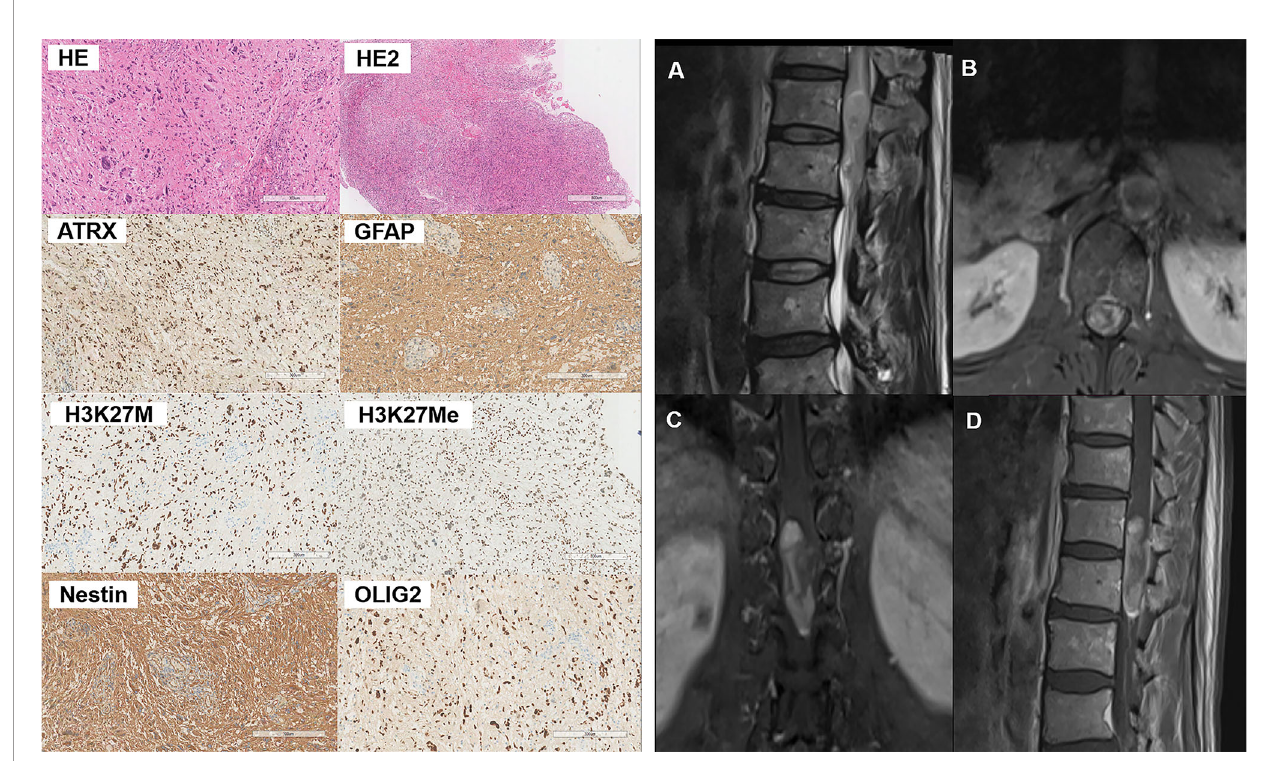
FIGURE 1 | Pathological and radiographical manifestations of the Case 4 patient. Left: Results of HE and immunohistochemical staining of the tumor tissues. Right: MRI images of the tumor that was located at the T12-L1 level. The tumor exhibited heterogenous iso-hyperintense with speckled hyperintense spots inside on T2WI (A) and patchy and cystic with nodules enhancement (B – D) on contrast-enhanced MR